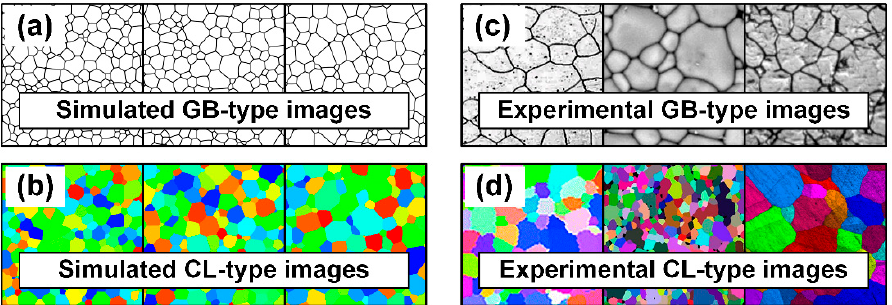
Figure 1. Examples of ( a ) GB- and ( b ) CL-type grains structures simulated with the phase-field model, and ( c ) GB- and ( d ) CL-type experimental images collected across the internet.